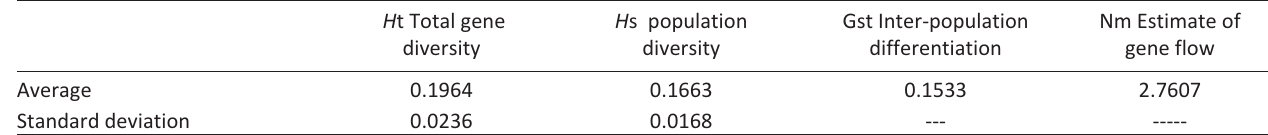
Table 6 ­ Assessment of the genetic variability among ten populations designated based on the ISSR analysis H t Total